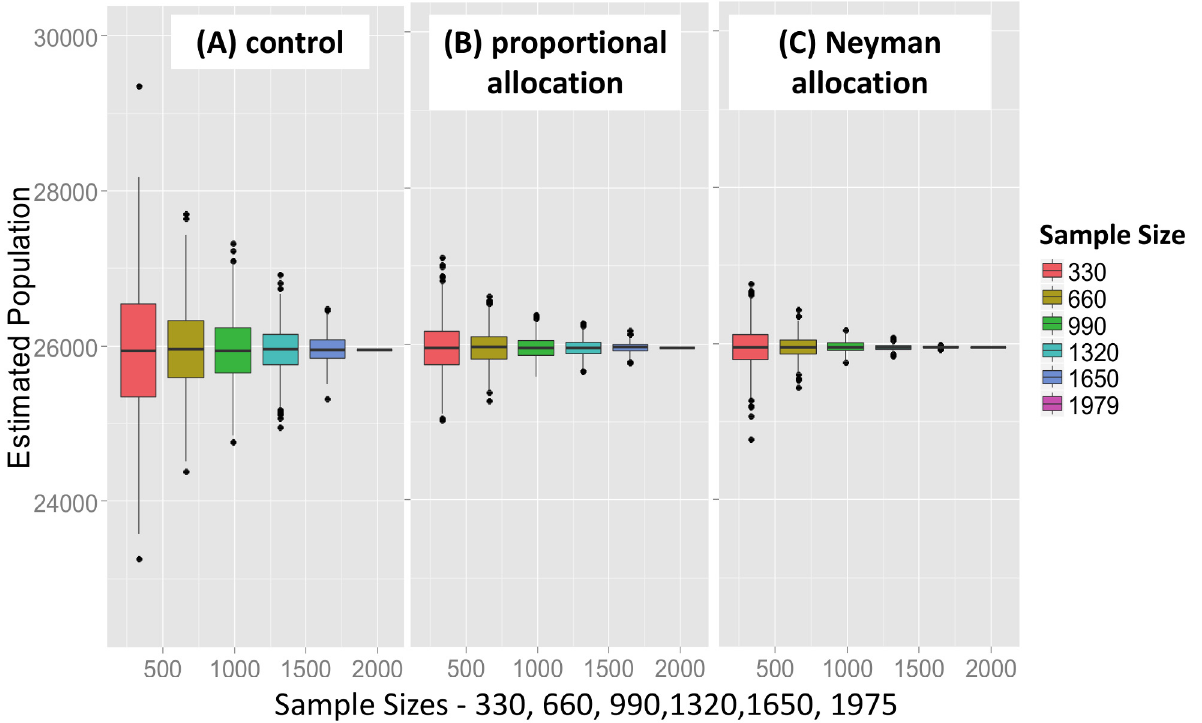
Fig 2. Relative uncertainty of optimized Horvitz-Thompson population estimates. Quantile boxplots (0.25, 0.75) showing the distribution of the stratified Horvitz-Thompson population estimates as a function of sample size and stratification protocol. The bar in each box is the median value of the estimate, while outliers deviating by one or more quantiles from the median are denoted as discrete points. (A) control — all 20 sections are placed in a single stratum (B) 4 strata, with proportional allocation for sample selection (C) 4 strata, with Neyman allocation for sample selection. Persons per residence was used as the stratification variable, and there were 1,000 simulations for each